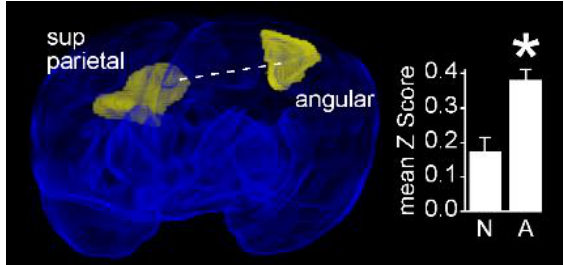
Figure 6. The left angular gyrus exhibits a decreased functional connectivity in infants with normal movement character compared with infants with jerky movement character. Obliquely projected 3D reconstructions of MRI images of cerebral grey matter and identified parcellated regions derived from a neonatal atlas. Dashed white line depicts the connectivity relationship. Inset: Fisher-transformed Z-scores ± 1 SEM. N: Normal; A: Abnormal. * P FDR < 0.05.